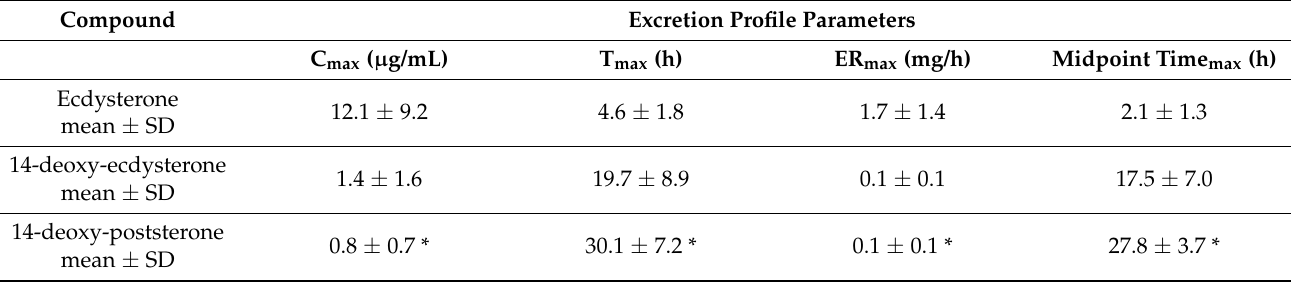
Table 5. Urinary excretion profile parameters calculated as the mean of 12 subject ± standard deviation (SD), after administration of a single dose of 50 mg of pure ecdysterone.